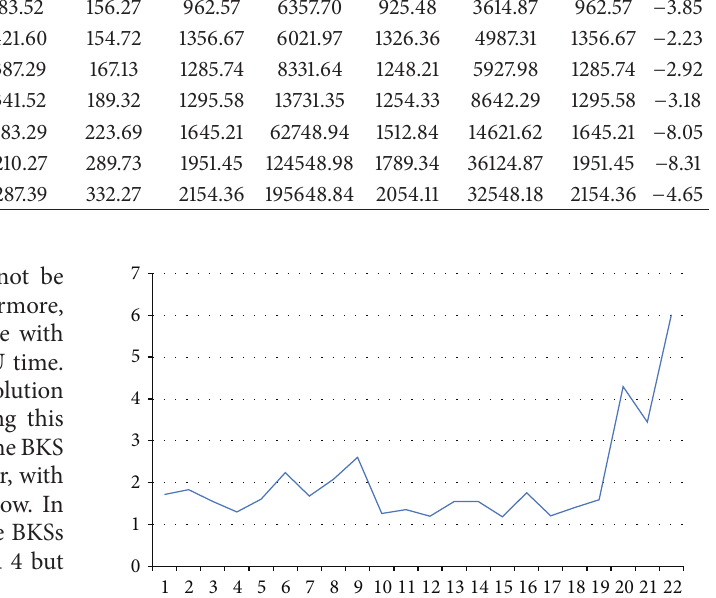
vertical axis indicates the SISEC CPU time divided by CG CPU